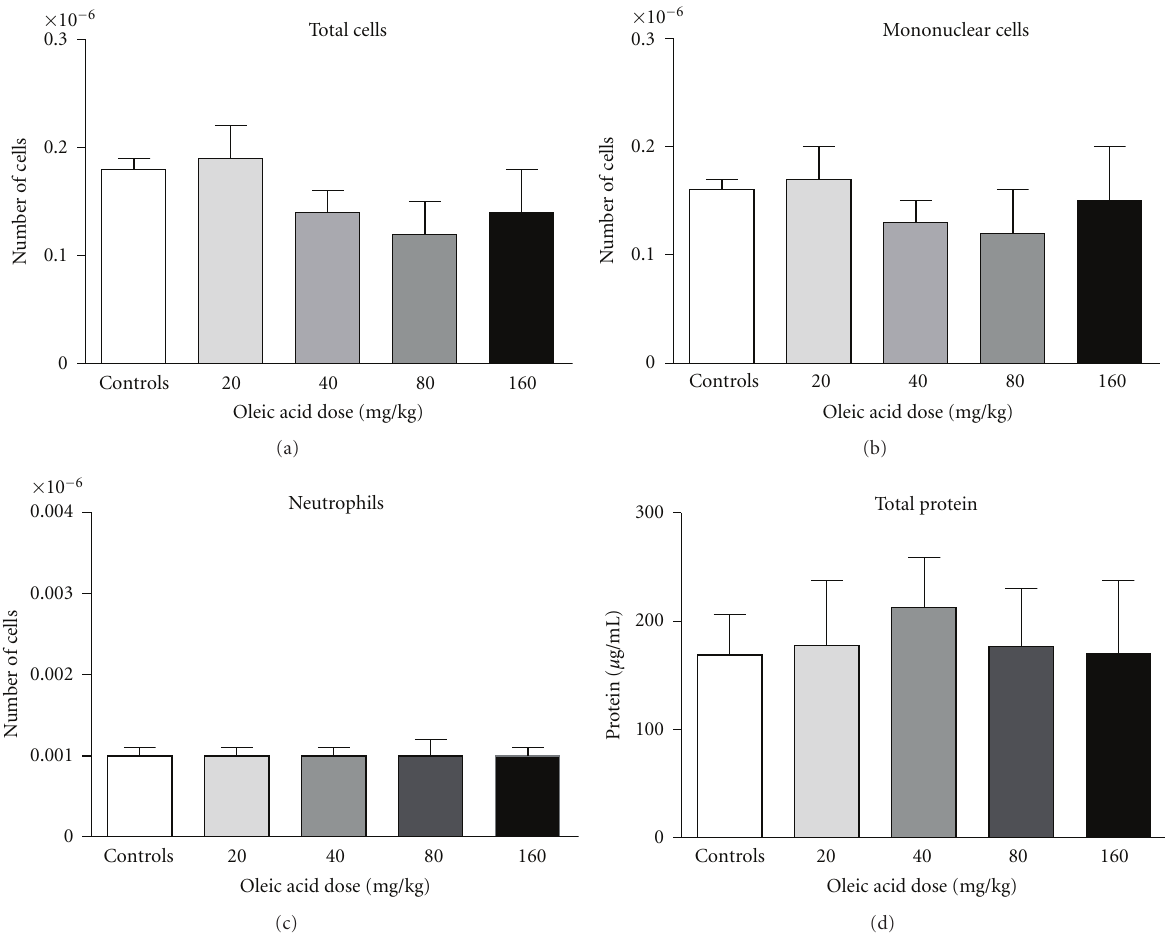
Figure 5: Leukocyte migration and protein extravasation in BALF after OLA administration by the gastric route. Bronchoalveolar fluids were collected 24 h after OLA administration. Total cells, mononuclear cells, and neutrophils were counted. Total protein in BALF supernatants was also assayed. Results represent the mean ± SEM of 3 independent